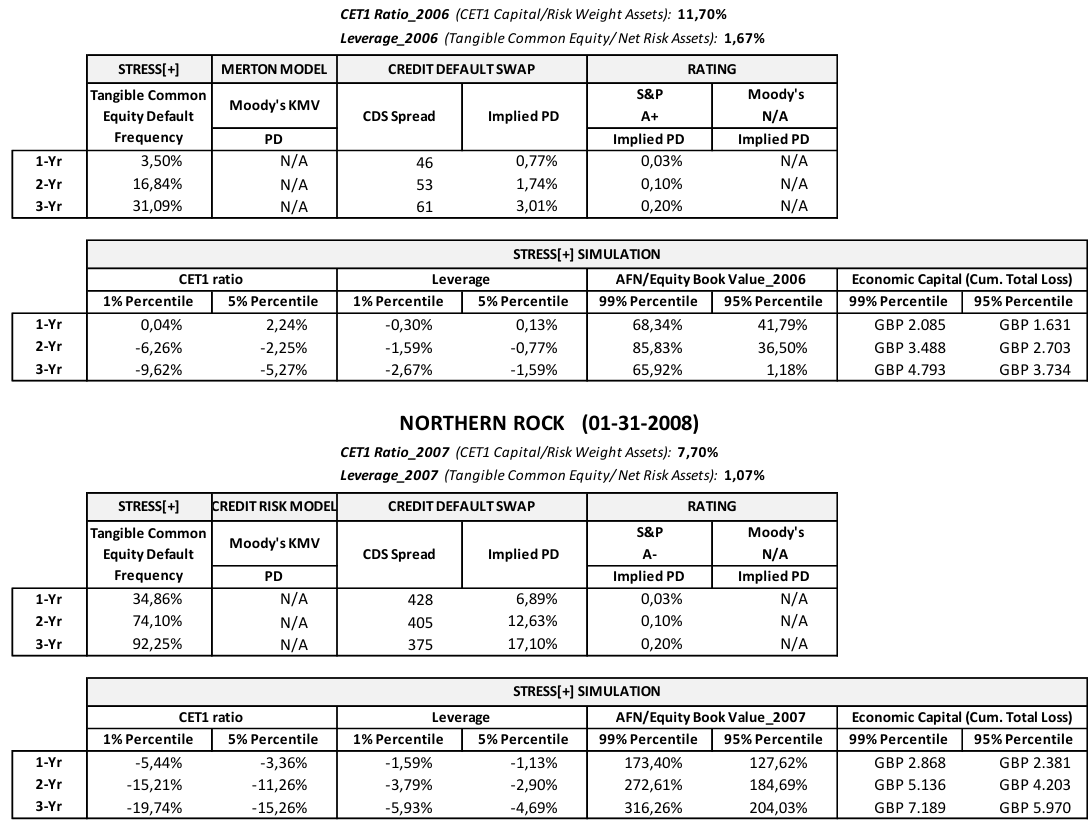
Figure A13. Backtesting comparative analysis: Northern Rock. (Source of CDS, KMV data, rating: Bloomberg, Moody’s KMV, Standard & Poor’s ).